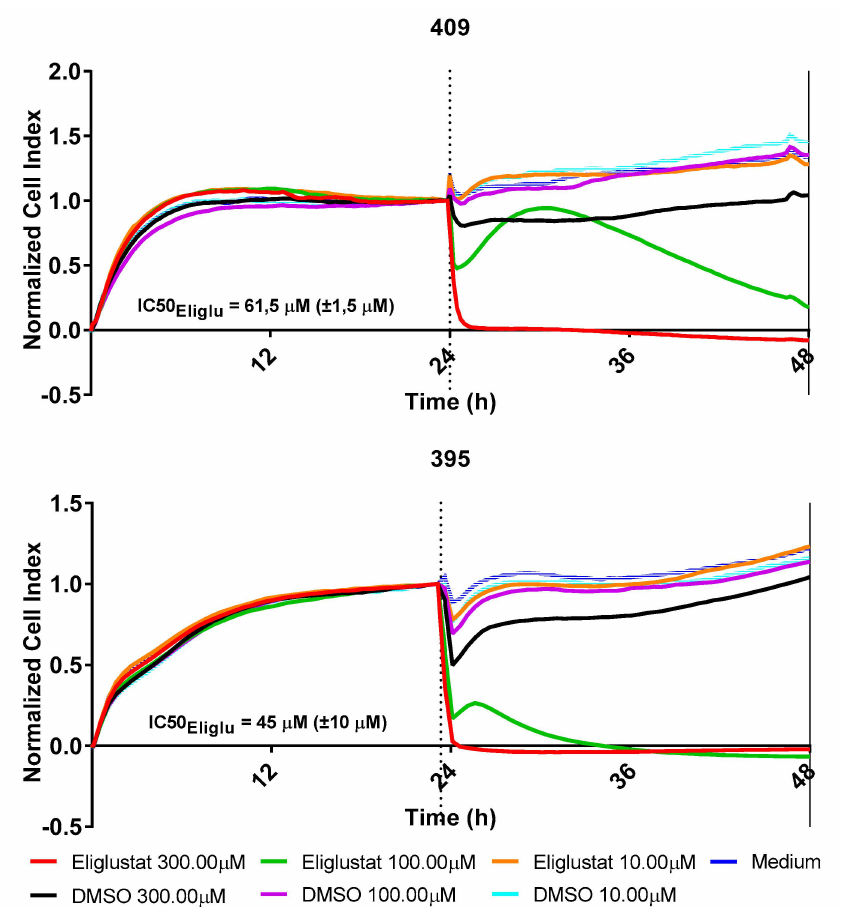
Figure 9. Eliglustat inhibits the proliferation of H3K27M-mutant DMG cells. Dose-response cell survival curves of H3K27M-mutant DMG primary tumor cells from two patients (no 395 and no 409) in response to eliglustat at the indicated concentrations. Due to clarity reasons, only the lowest non effective concentration (10 µ M) is shown. DMSO was used as control; all experiments were per- formed two times and showed similar results. IC50 Eliglu indicates the mean half maximal inhibitory concentration of eliglustat and the range from two independent experiments for each